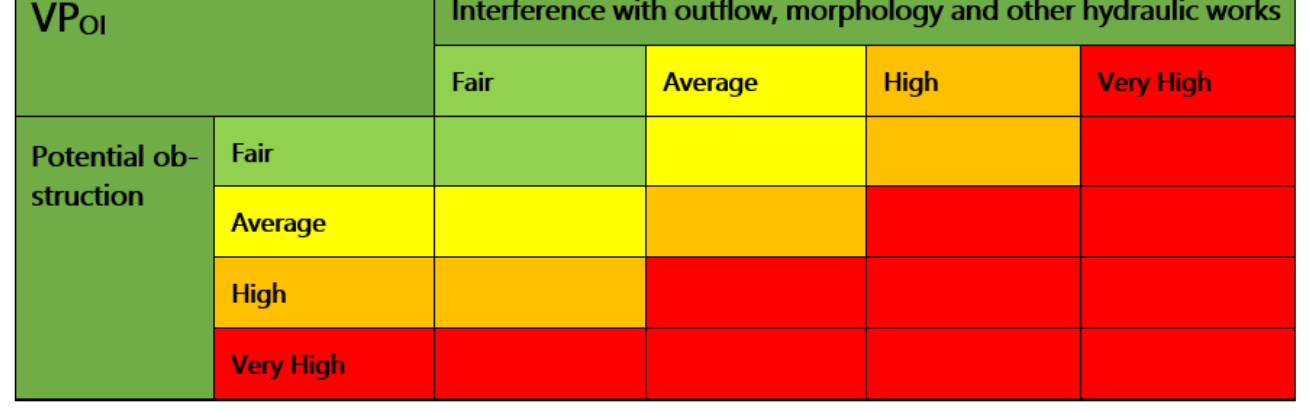
Figure 1. Matrix for the evaluation of VP OI .